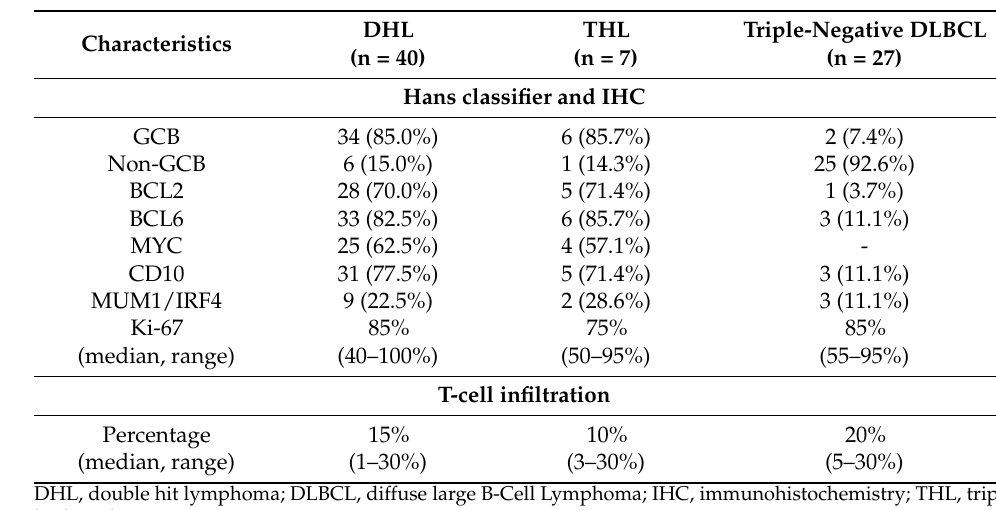
Table 3. Histopathological characteristics in the study group.